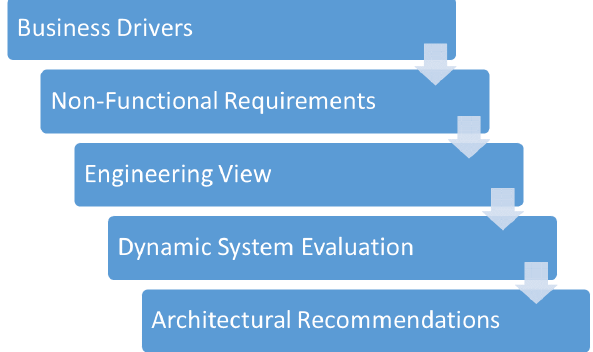
Figure 1. Proposed method for the framework for automated monitoring in